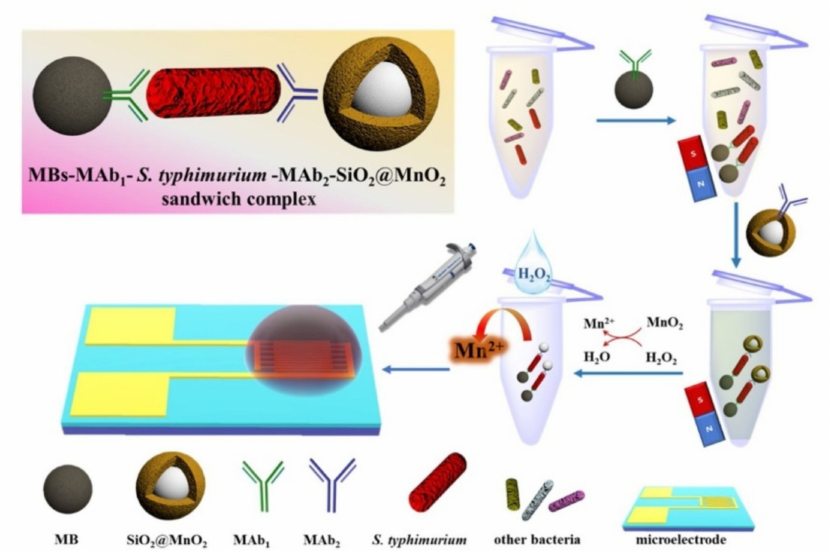
Figure 5. Illustration of the detection of S. typhimirium using immunomagnetic separation and impedance monitoring of the release of Mn 2+ from the SiO 2 @MnO 2 nanocomposite. Adapted with permission from [65] Copyright 2020,